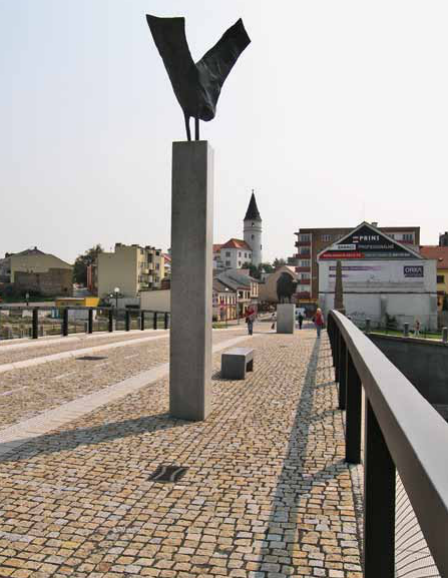
fig. 2. Michal Kohout, Zdeněk jiran: new wing of the townhall in České Budějovice, 1997–2000.